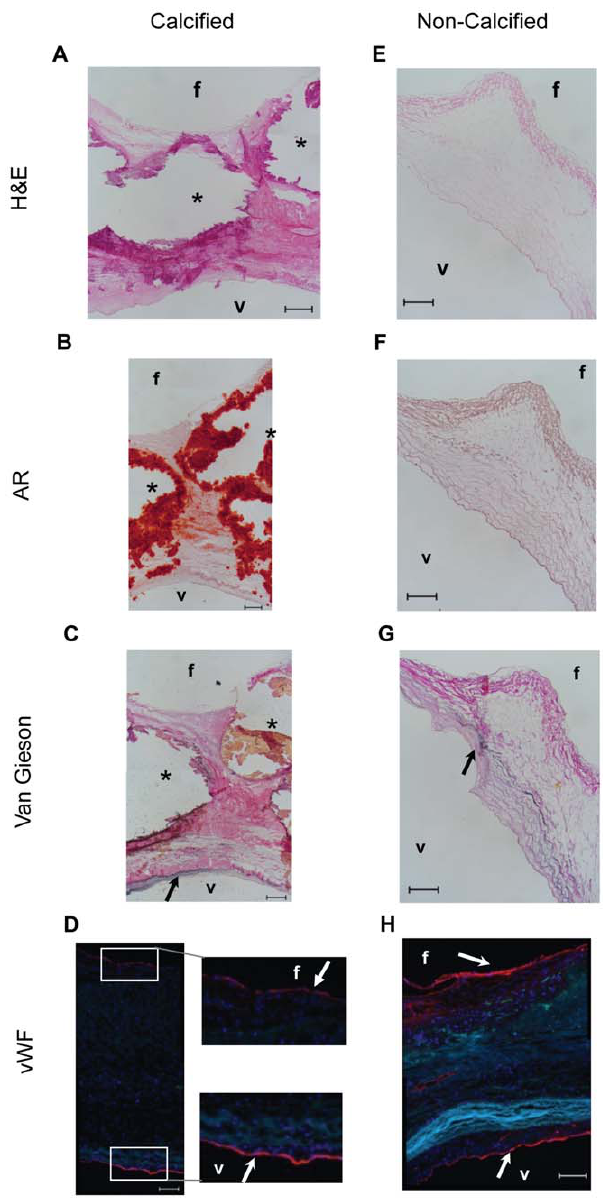
Figure 1. Calcification and endothelial staining of AV cusps. Valves were obtained from either heart transplant (non-calcified) or valve replacement (calcified) surgeries, snap frozen and sectioned. Sections were then stained for H&E ( A , E ), alizarin red ( B , F ), Verhoeff Van Giessen ( C , G ) or von Willebrand factor ( D , H ). Representative staining (n=12 patients) shows side-specific calcification (*) in calcified leaflets ( B , F ), while maintaining an intact endothelial layer ( D , H : arrows). Verhoeff Van Giessen stain was used to stain for elastin (shown in black, arrows) to help in leaflet orientation ( C , G ). f: fibrosa, v: ventricularis.